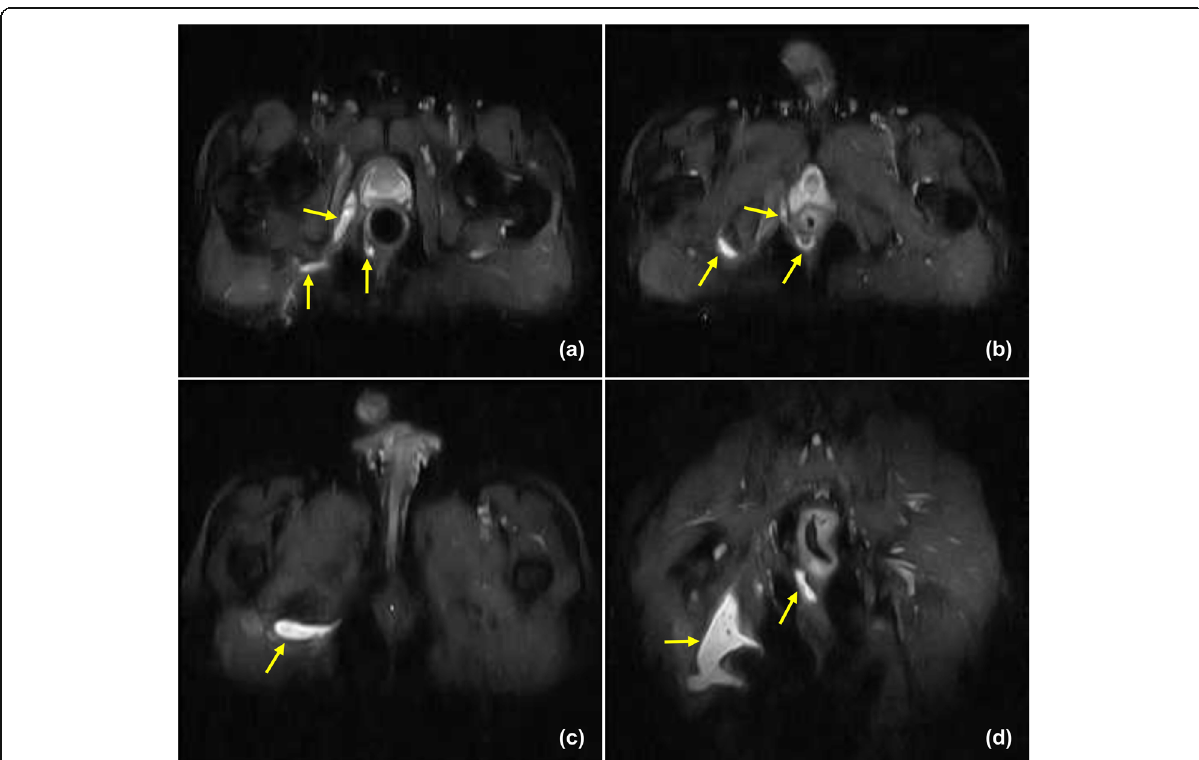
Fig. 13 MR Pelvis FS T2W. a – c Axial and d coronal image of a complex fistula showing transsphincteric track with gluteal abscess (yellow